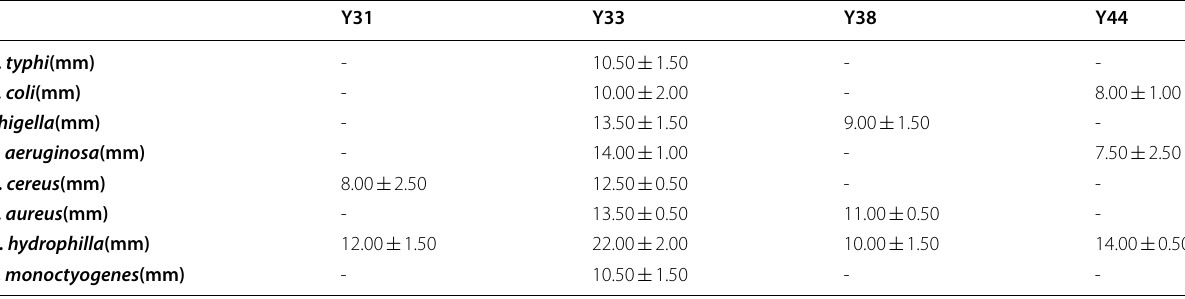
Values represented as mean